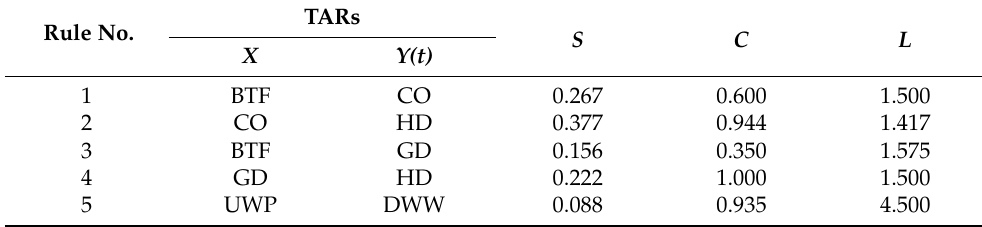
Table 6. TAR results for tankers.